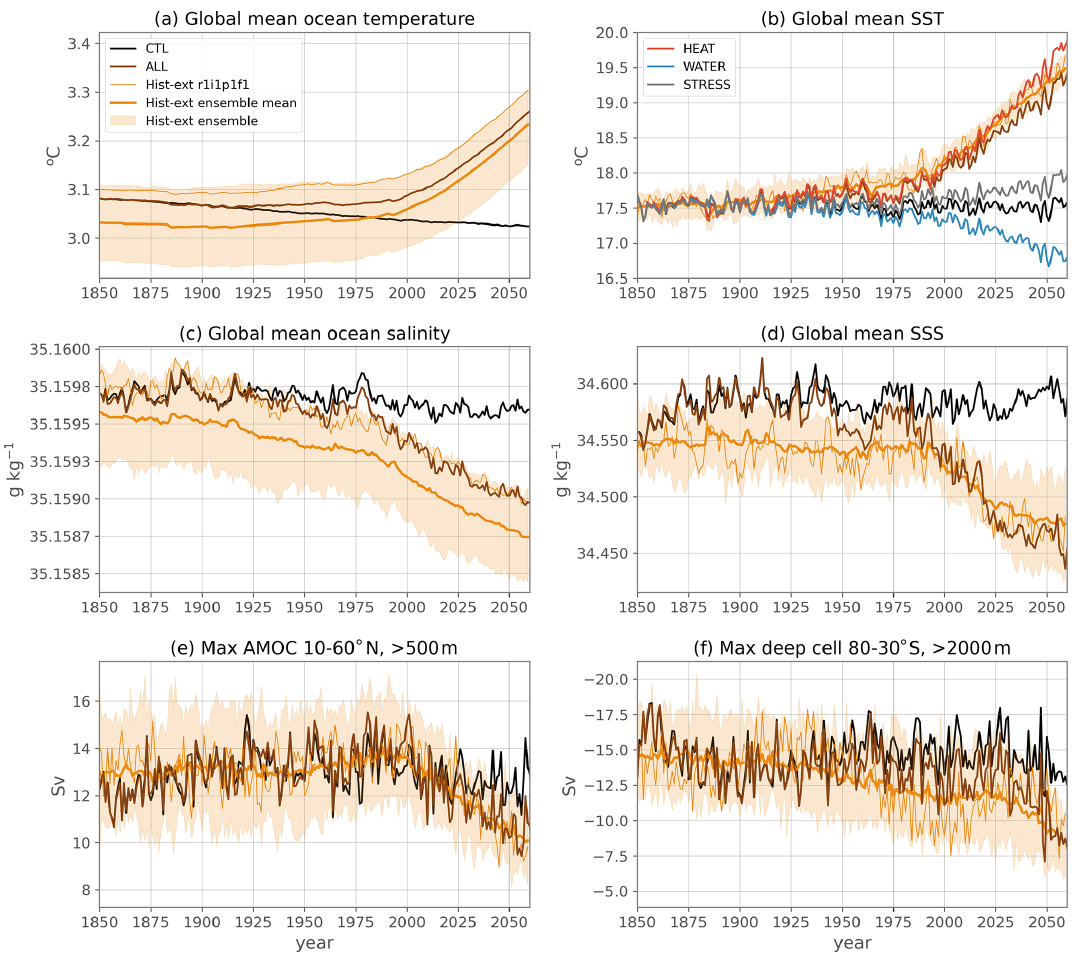
Figure 10. Annually averaged diagnostic time series for the flux-forced ocean-only CTL (black), ALL (brown) and the historical-extended large ensemble (orange shading is the full inter-member spread (minimum to maximum), the bold orange line is the ensemble mean and the thin orange line is one individual member). In panel (b) , the SST is also represented for the ocean-only sensitivity experiments HEAT (red), WATER (blue) and STRESS(grey). Panels (a) and (c) represent averages over the entire, full-depth, ocean